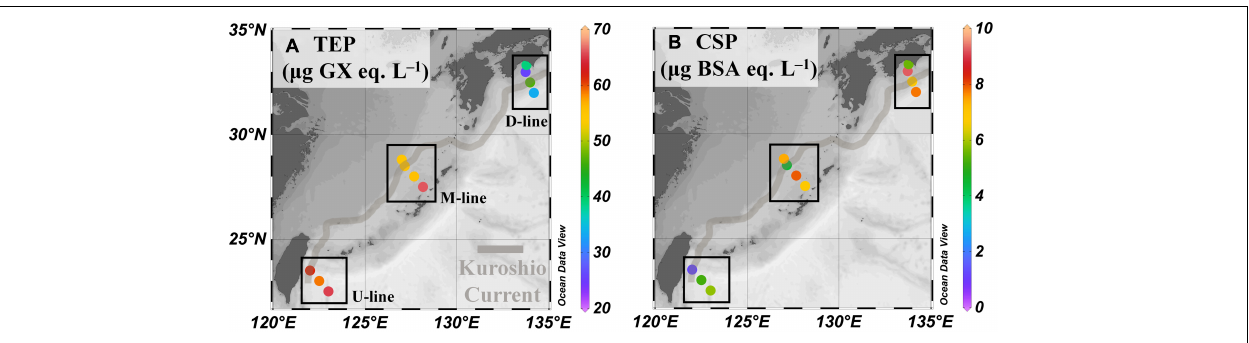
at on-shore stations on the D- and M-lines (D1, D2,